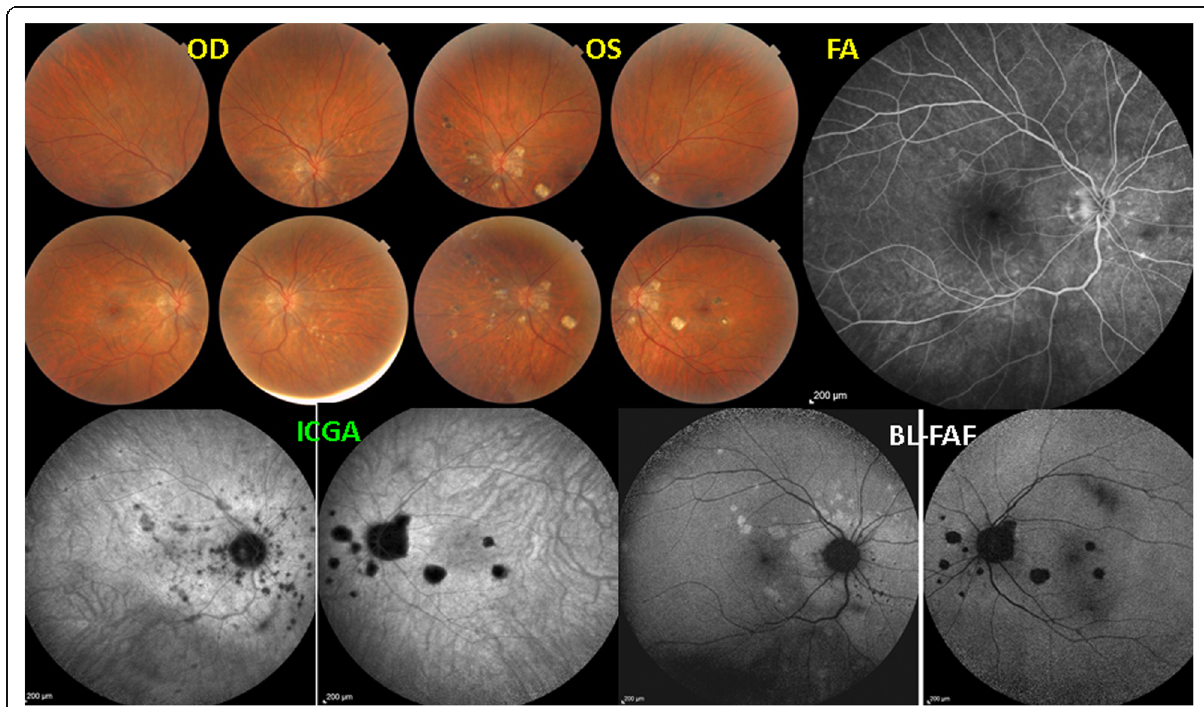
Fig. 17 Multifocal Choroiditis. This patient had several episodes of MFC in the left eye with numerous remaining chorioretinal scars (fundus photograph OS, top middle, ICGA – OS, BL-FAF -OS. She consulted again for photopsias OD. No lesions visible on fundus OD, nor on FA, but numerous occult lesions visible on ICGA and BL-FAF OD. (1st and 3rd frame from the left, bottom)